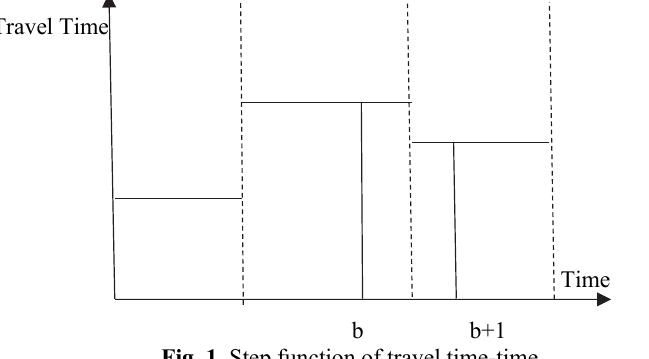
Fig. 1. Step function of travel time-time